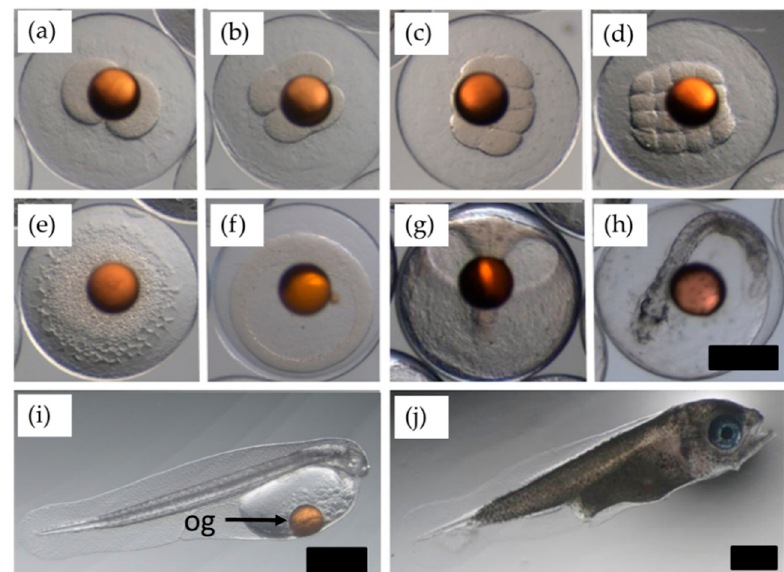
Figure 2. Development of second filial generation (F2) h ā puku ( Polyprion oxygeneios ) incubated at 13.5 °C. Gametes were collected by strip-spawning and fertilized in vitro. ( a ) Two-cell stage (~3.5 h post-fertilization); ( b ) four-cell stage (~4.5 h post-fertilization); ( c ) eight-cell stage (~5.5 h post-fertilization); ( d ) 16-cell stage (~6.5 h post-fertilization); ( e ) blastula (~14 h post-fertilization); ( f ) gastrula (36 h post-fertilization); ( g ) neurula (51 h post-fertilization); ( h ) tail-free embryo (108 h post-fertilization); ( i ) 2 day old larva; ( j ) 20 day old larva. Scale bar = 1 mm. Abbreviations: og = oil globule.